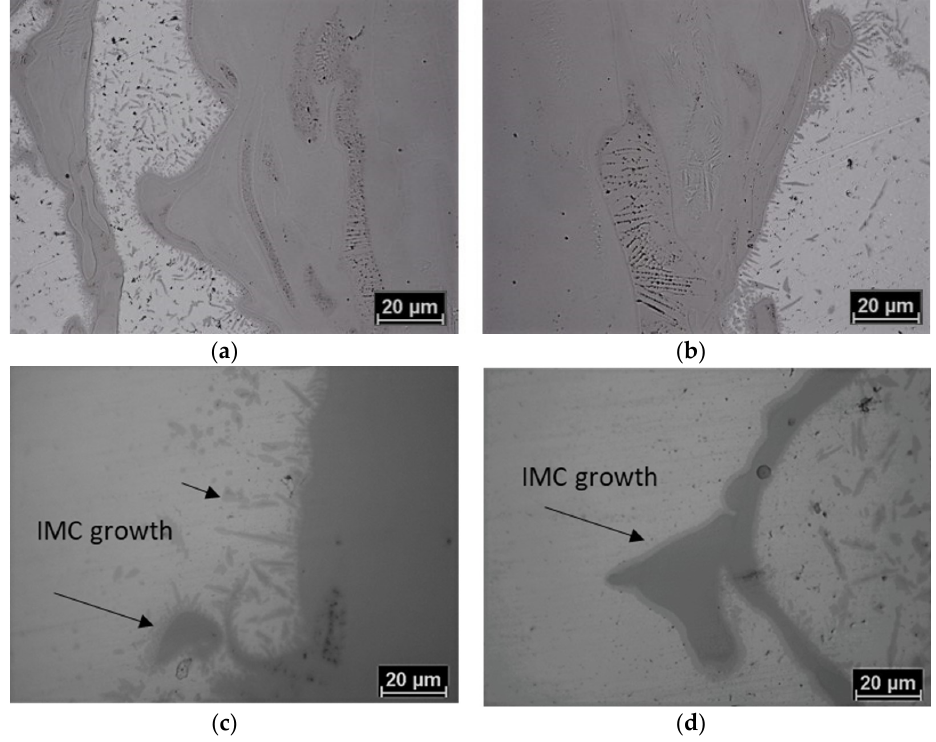
Figure 13. Optical micrographs before ( a , b ) and after ( c , d ) SRHT for welds 3 T ( a , c ) and 3B ( b , d ).